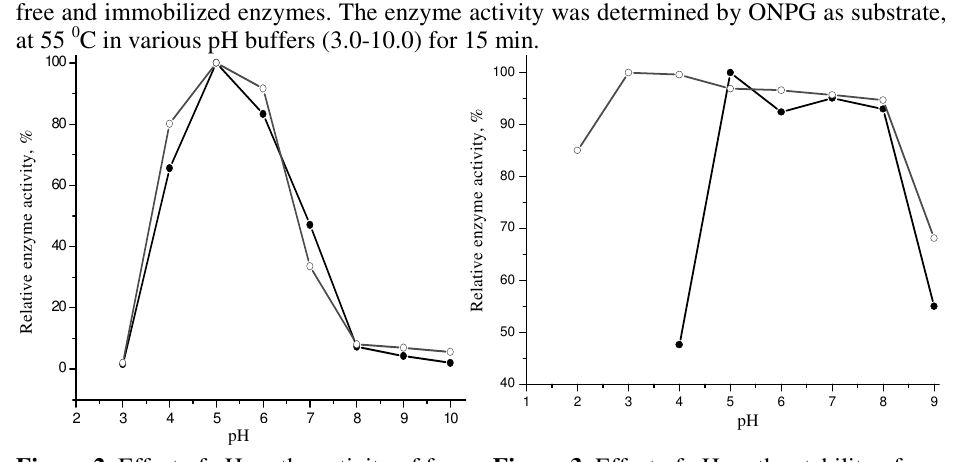
Figure 2. Effect of pH on the activity of free (a) and immobilized (b) enzymes